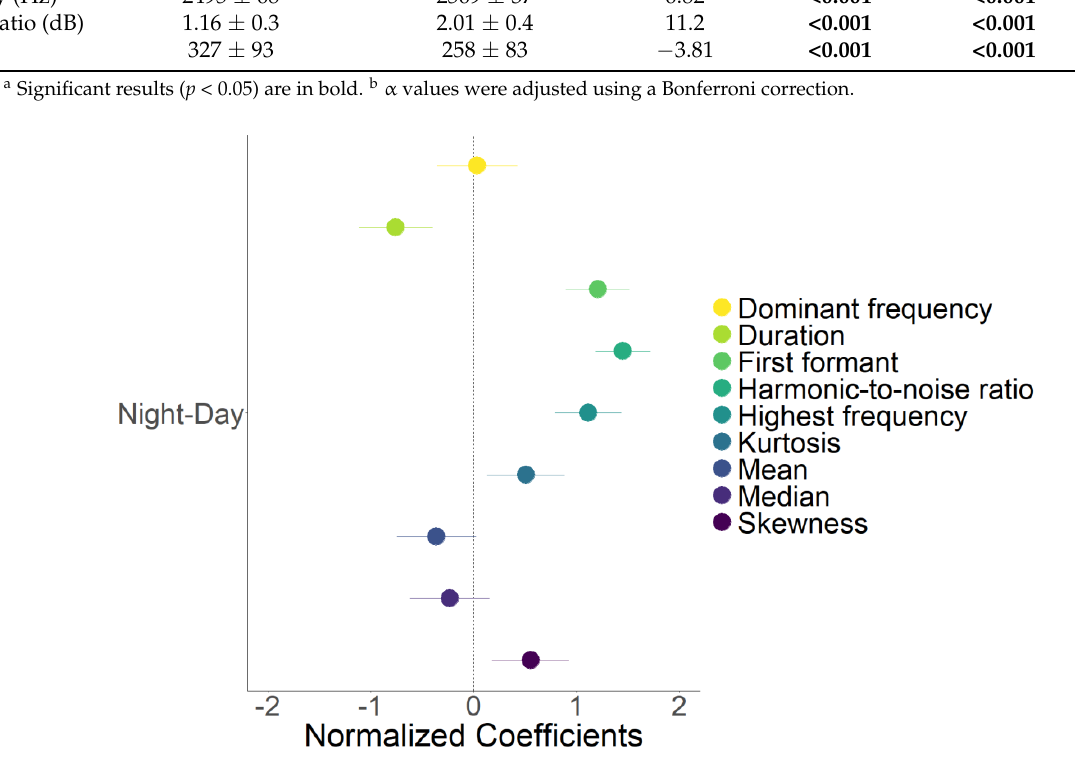
Figure 3. Results of linear mixed models showing the effect of the time howling bouts were emitted (night or day) on nine acoustic parameters. The reference level for the models (i.e., the intercept) was “day”. Dots are the normalized coefficients values and lines represent the 95% confidence intervals. Coefficients were normalized by subtracting raw values by the mean and dividing by the standard deviation. Positive values indicate higher values for nocturnal howling bouts.